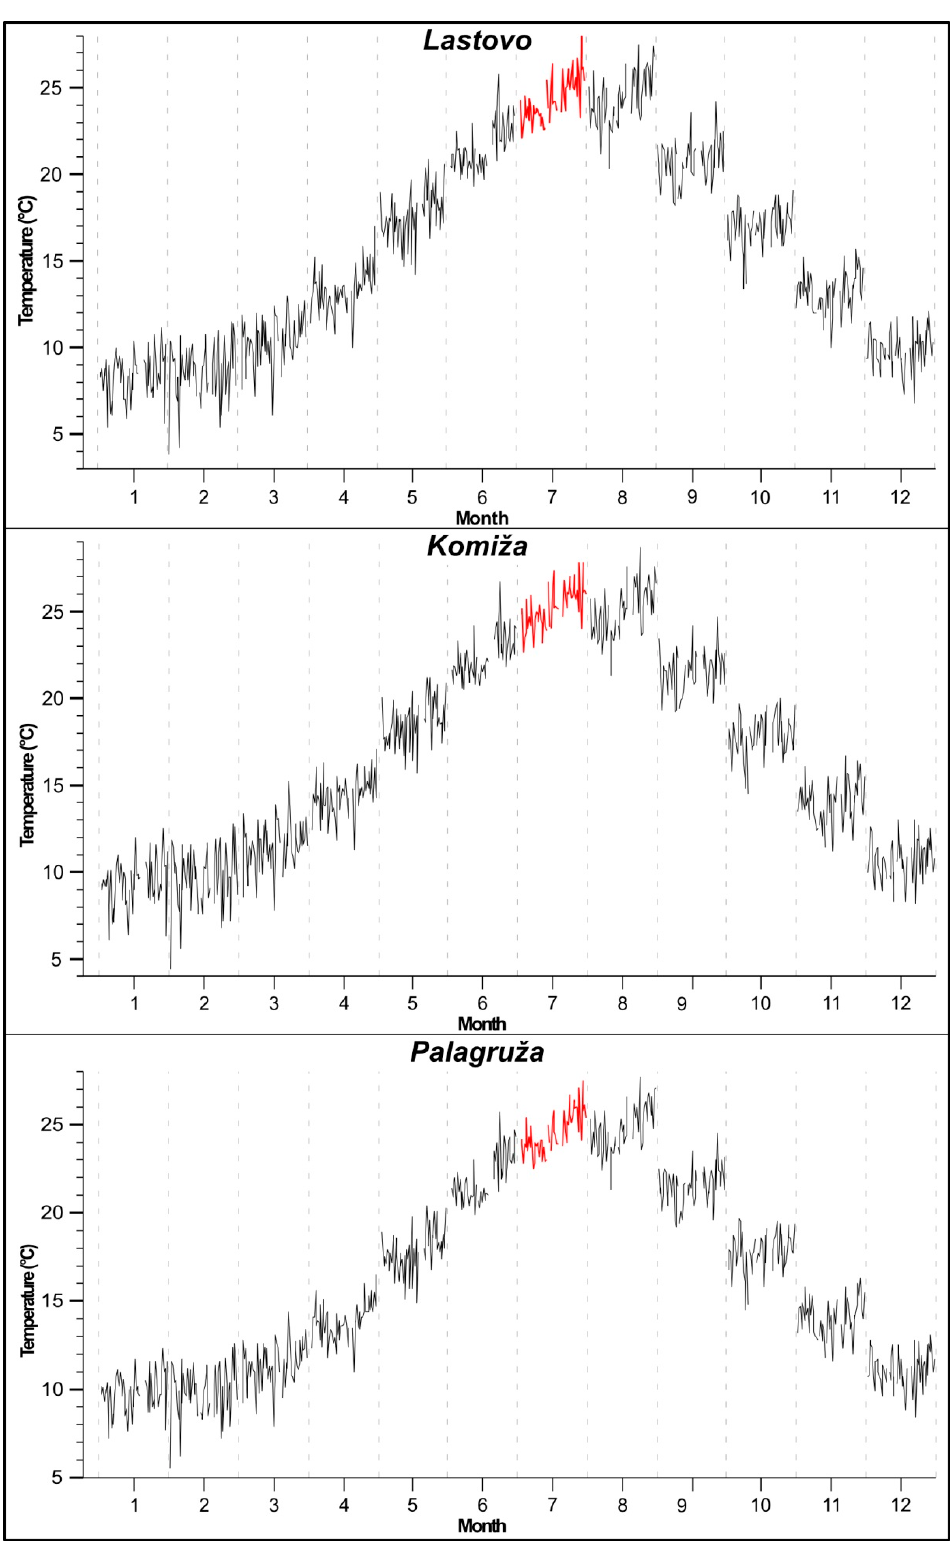
Figure 5. Monthly subseries plot of the mean air temperature at the Lastovo, Komiža, and Palagruža stations. Within a month, the mean monthly values were plotted in chronological order over the period 1958–2018 (Table 2). The time series of July (in red) shows the most prominent increasing trends as suggested by the highest linear correlation coefficient r values (Table 4).